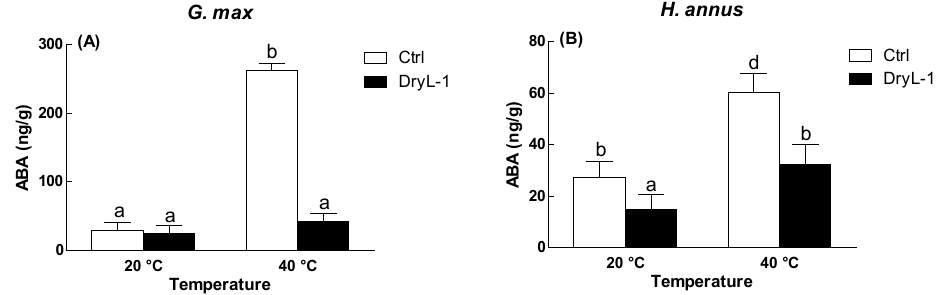
Fig. 5: Analysis of ABA quantification via GC MS in G. max (A) and H. annuus (B) plants grown at normal (25 °C) and high (40 °C) temperatures with and without A. violaceofuscus . Data are means of triplicate with standard error bars. Different letters are significantly different (p < 0.05) as estimated by Duncan’s Multiple Range Test